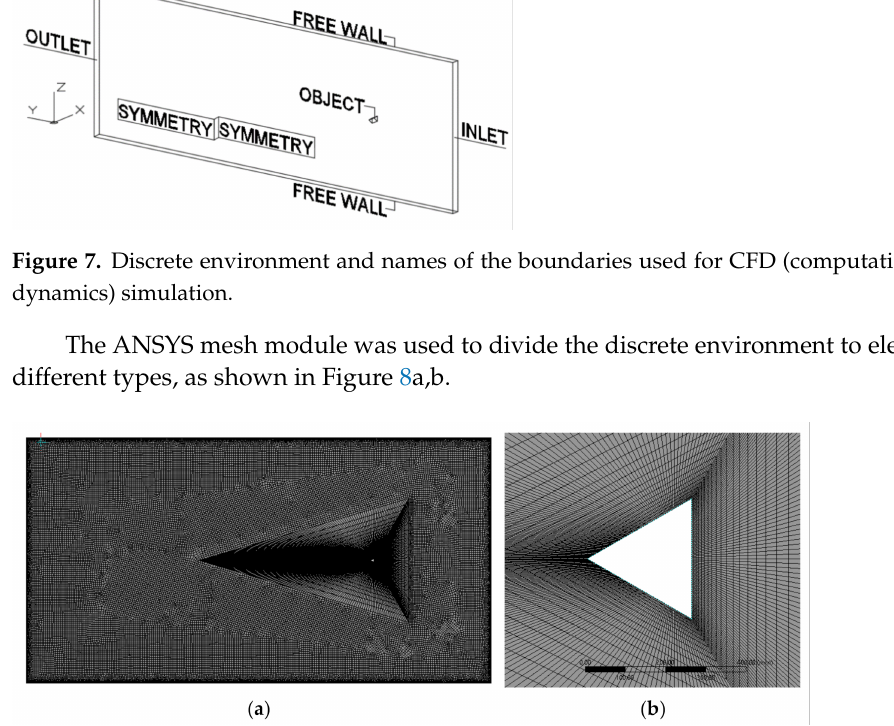
Figure 8. Generated mesh for CFD simulation: ( a ) Whole discreet environment; ( b ) Close proximity of analyzed